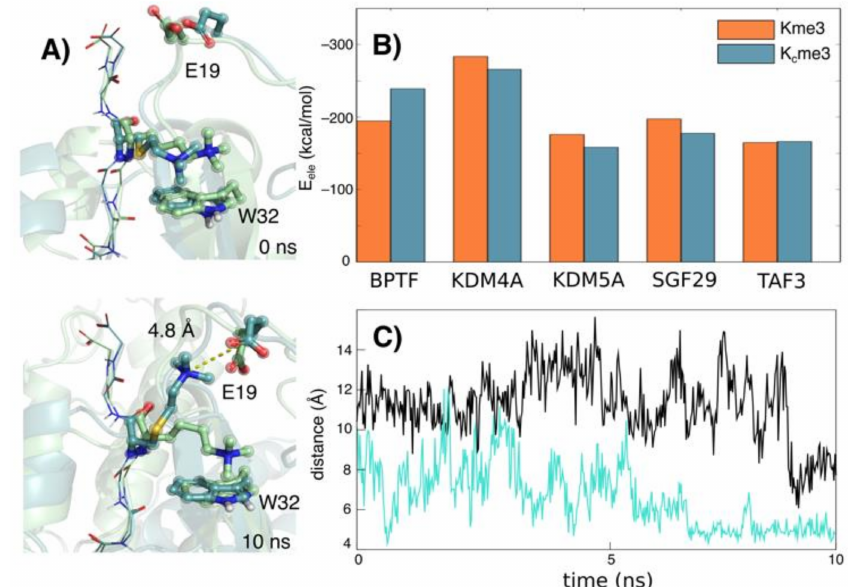
Figure 3. ( A ) Snapshots of BPTF PHD complexed with H3 tail backbone (lines) containing K C me3 (cyan) and Kme3 (green) active sites at 0 and 10 ns; ( B ) ∆ E ele contributions of ligands Kme3 and K C me3 from MM-GBSA binding free energy calculations; ( C ) distance vs. time plot of side N ε + atoms of Kme3 (black) and K C me3 (cyan) to carboxyl group of BPTF PHD residue Glu19